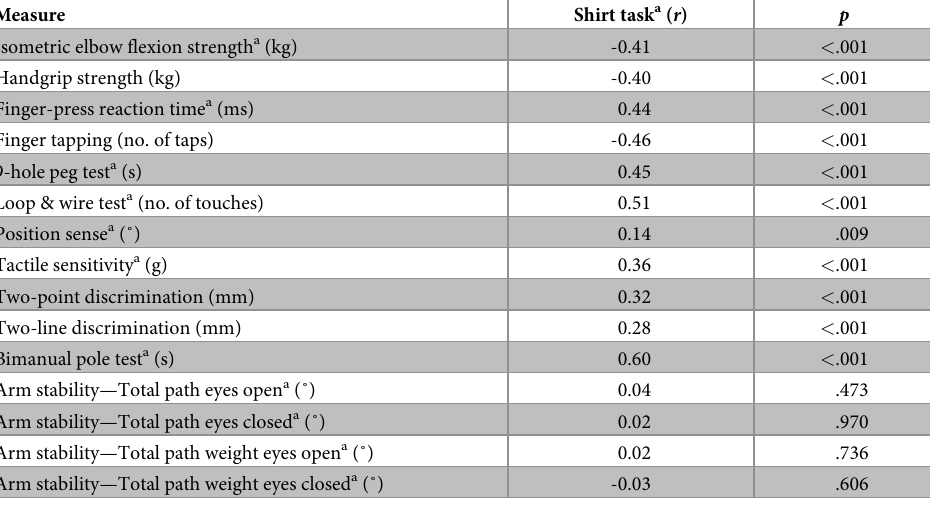
Table 8. Correlations between individual upper limb test performance and performance in the shirt task.